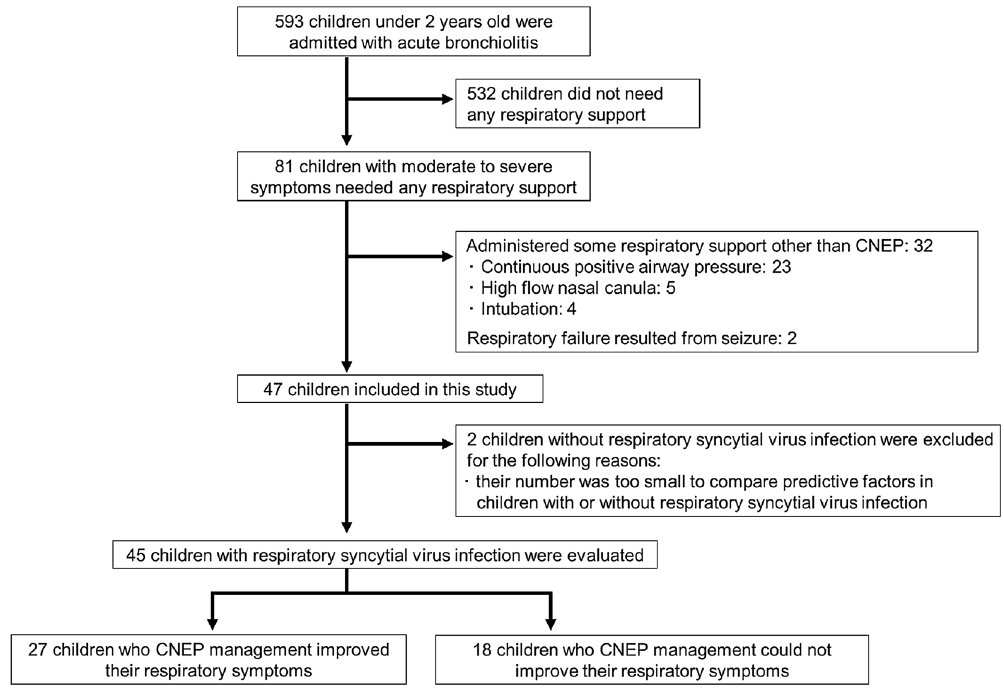
Figure 1. Patient flowchart. Of 593 children aged under 2 years who were admitted due to acute bronchiolitis, 45 children with moderate to severe symptoms of respiratory syncytial virus requiring respiratory support were evaluated in this